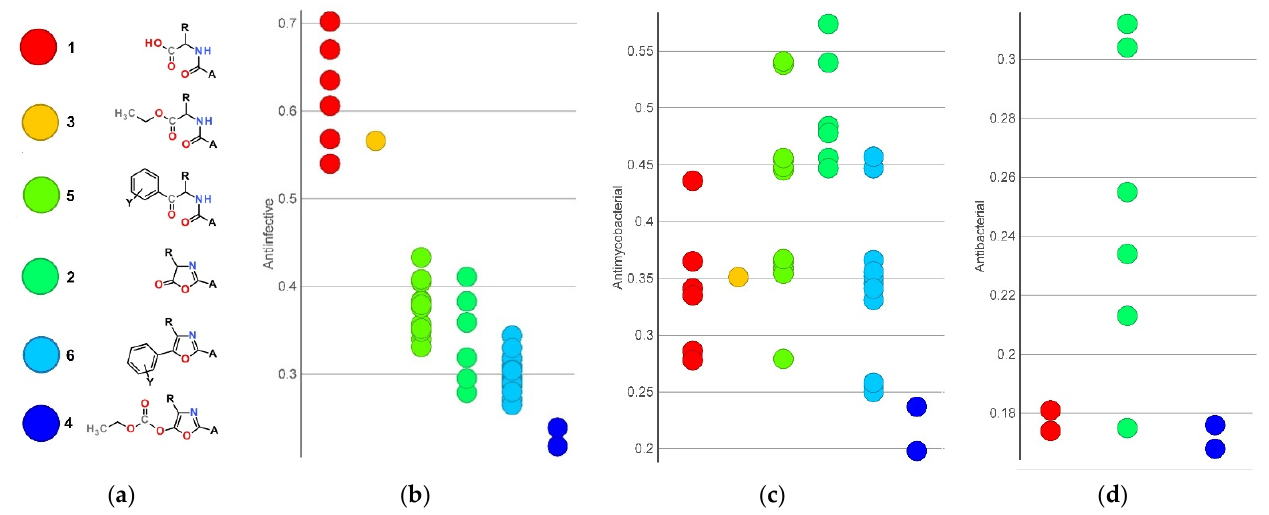
Figure 1. Pa values as predicted by the PASS application: ( a ) color codes for classification; ( b ) Pa values for anti-infective effect; ( c ) Pa values for antimycobacterial effect; ( d ) Pa values for antibacterial effect.